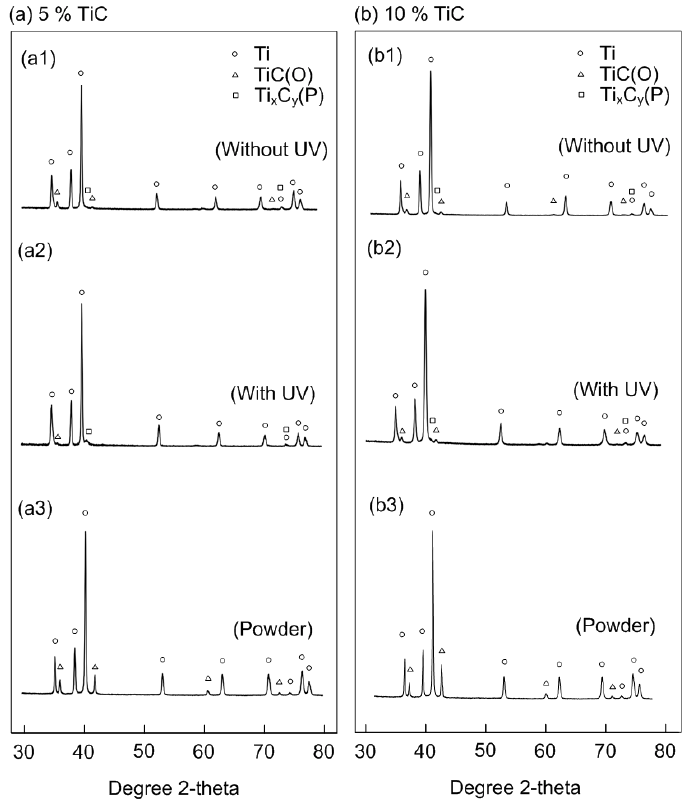
Figure 3. The effects of ultrasonic vibration and TiC content on the phase compositions of TiC-TMC coatings: ( a ) 5% TiC; ( b ) 10% TiC. Table 2. Phase compositions of the feedstock powder and the TiC-TMC coatings with 5% TiC. Conditions